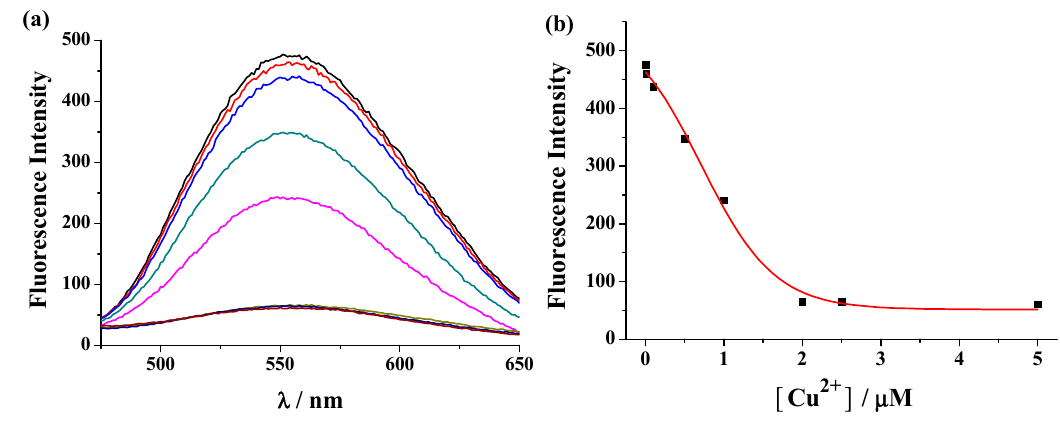
Figure 2. The emission spectra ( a ) and fluorescence intensity ( b ) at 552 nm of 2 μ M SGHK-Dns in the presence of different concentrations of Cu 2+ (from top to bottom: 0, 0.01, 0.1, 0.5, 1, 2, 2.5 and 5 μ M).